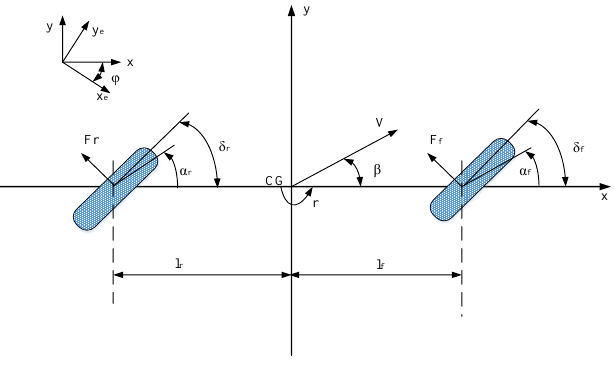
Figure 1. The 2DOF vehicle model.